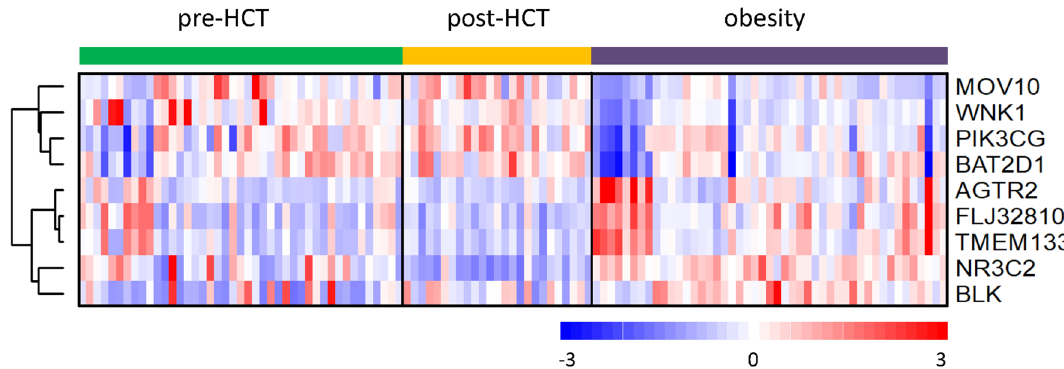
Figure 1. Differences in the expression of blood pressure-associated genes between pre-HCT, post-HCT, and obesity control group. Microarray results are shown as a heatmap and include the hypertension-associated genes for which significant differences in expressions between the study groups were found. Colored rectangles represent transcript abundance in the blood. The intensity of the shading is proportional to the standardized values (between − 3 and 3) from each microarray, as indicated on the bar below the heat map image. Hierarchical clustering was performed with the dChip (Ver 2/25/09+) software (https:// sites. google. com/ site/ dchip soft) using Euclidean distance and the average linkage